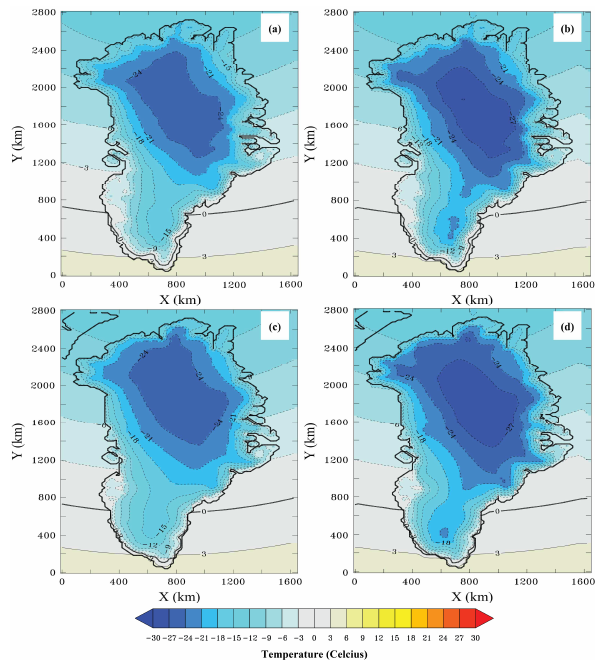
Figure 4. Sensitivity to different temperature forcings for the GrIS. The near surface 2 Fig. 4. Sensitivity to different temperature forcings for the GrIS. air-temperature (in °C) over Greenland for a) after 1 year of model time forced with 3 The near surface air-temperature (in ◦ C) over Greenland for (a) af- EISMINT-3 temperatures, b) after 1 year of model time forced with Hanna modified 4 ter 1 year of model time forced with EISMINT-3 temperatures, temperatures, c) after 50,000 years of model time forced with EISMINT-3 5 (b) after 1 year of model time forced with Hanna modified temper- temperatures and d) after 50,000 years of model time forced with Hanna modified 6 atures, (c) after 50000 years of model time forced with EISMINT-3 temperatures. 7 temperatures and (d) after 50000 years of model time forced with Hanna modified